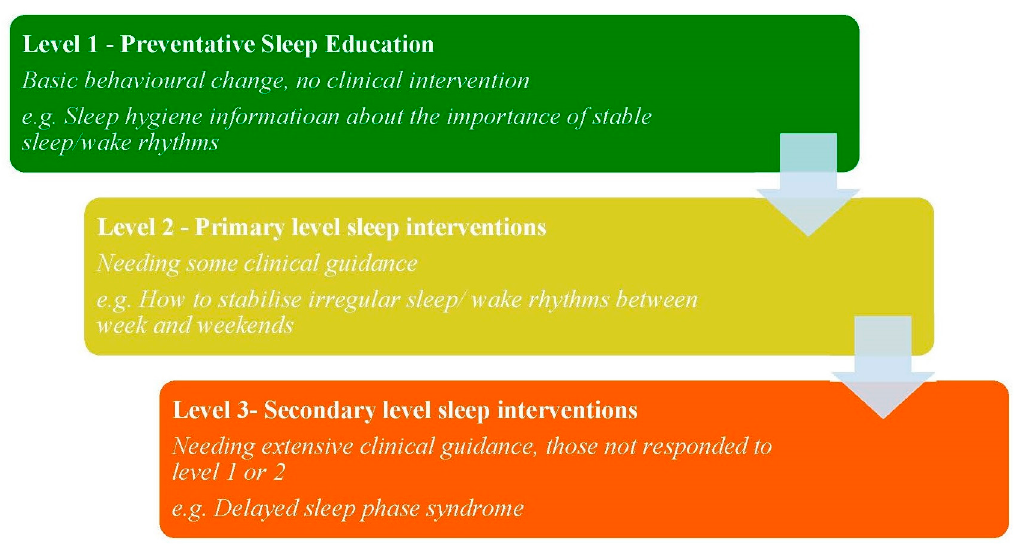
Figure 1. Proposed adaptation of the stepped care model for sleep education.